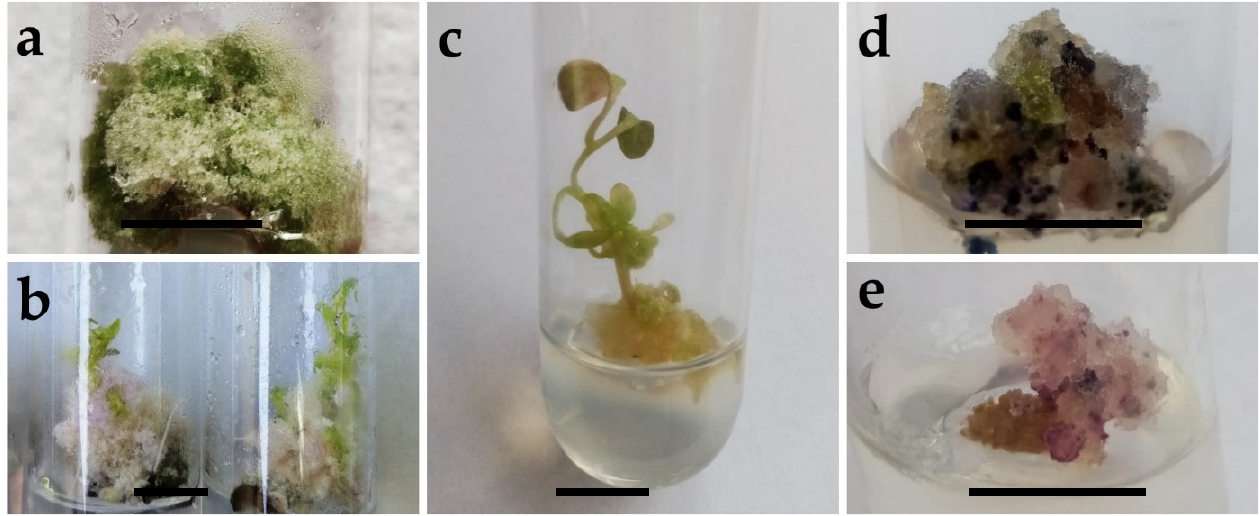
Figure 3. Callus aspect of SB variety in the culture media tests: ( a ) C 1 ; ( b ) C 2 ; ( c ) C 3 ; ( d ) C 4 , ( e ) C 5 . Scale bar represents 1 cm.